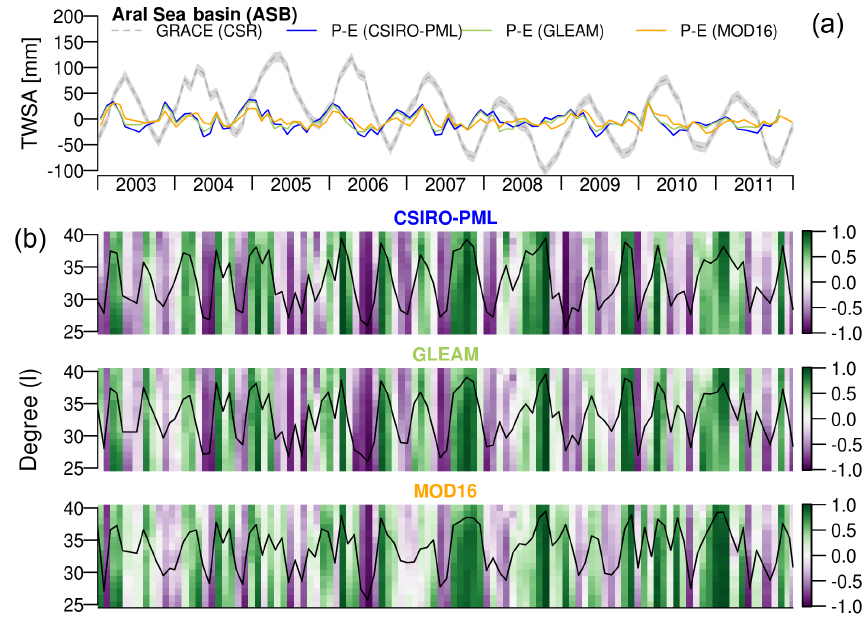
Figure 6. Top: anomalies of the terrestrial water storage (TWSA) observed by GRACE (with 20mm uncertainty bounds) and P − E using three global evaporation products over the Aral Sea basin. Below: varying degree correlation measure ( r l ) with time and degree (from 25 to 40) using the three global evaporation products. The average r l is shown as a time series (black line). The degree correlation measure can range from − 1 to 1, as shown in the colour scale on the secondary axis.